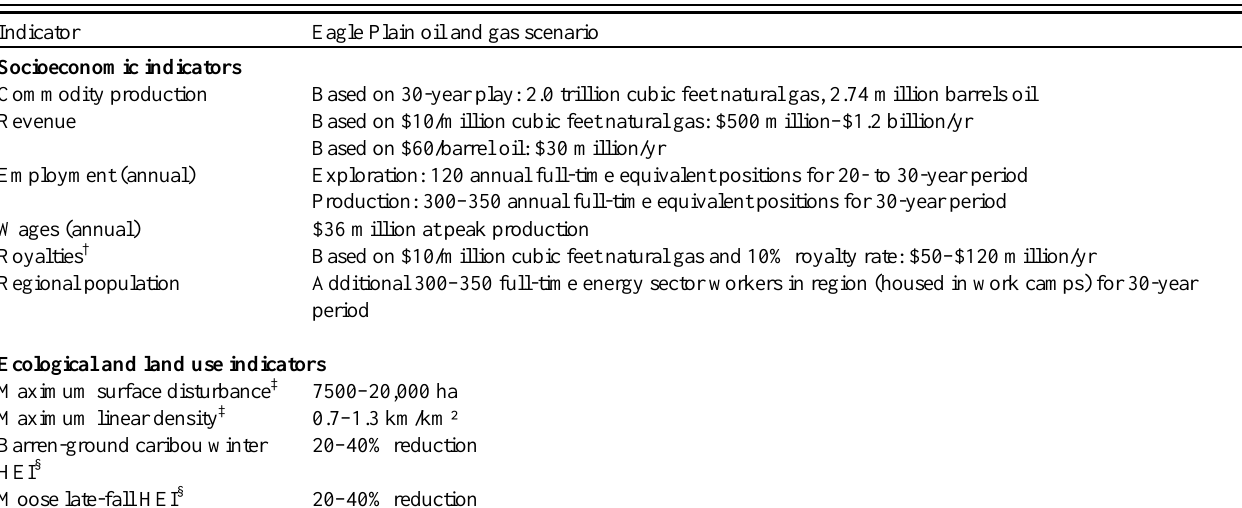
Table 4 . Eagle Plain oil and gas scenario